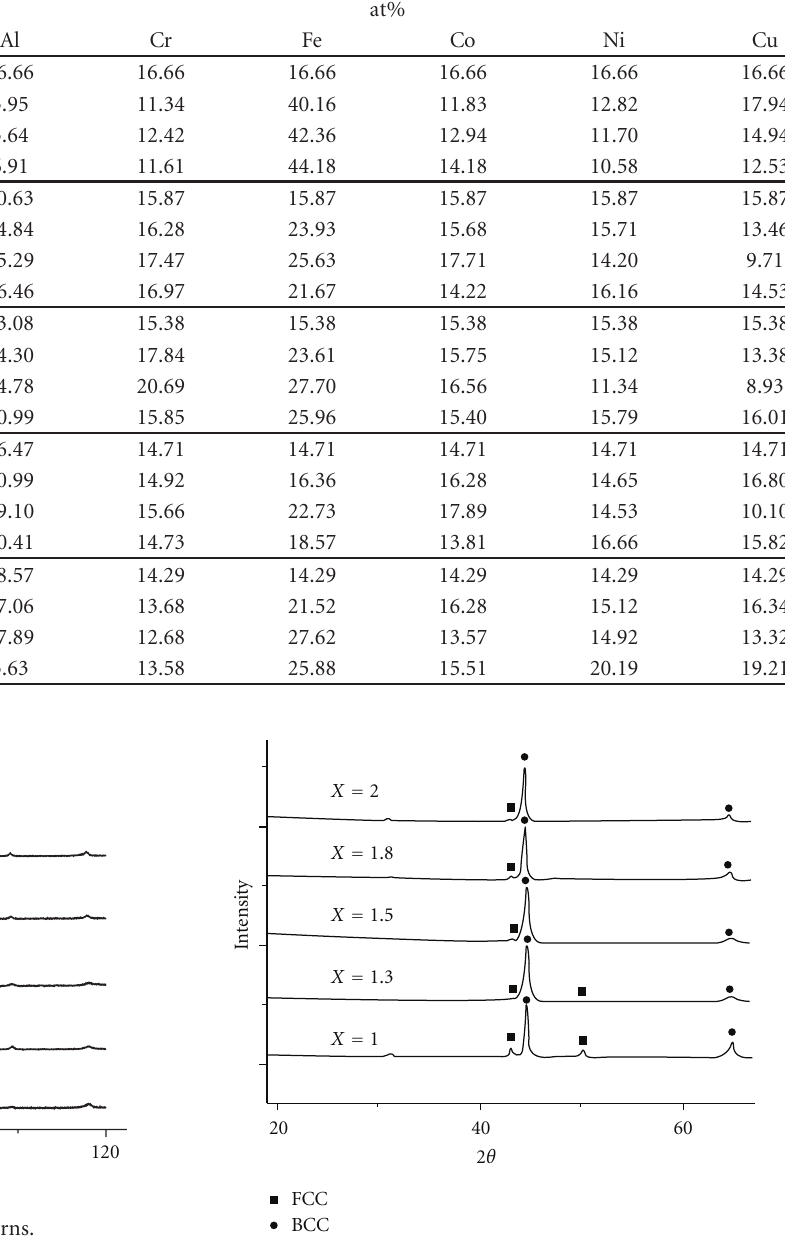
Figure 4: The detailed main di ff raction peak of XRD.